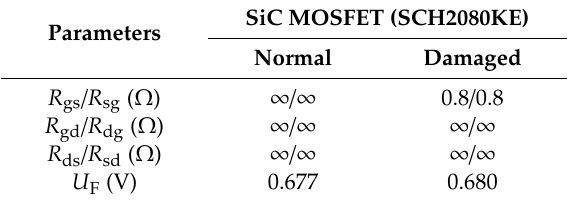
Table 1. The terminal impedance and body diode forward voltage drop SiC MOSFET.